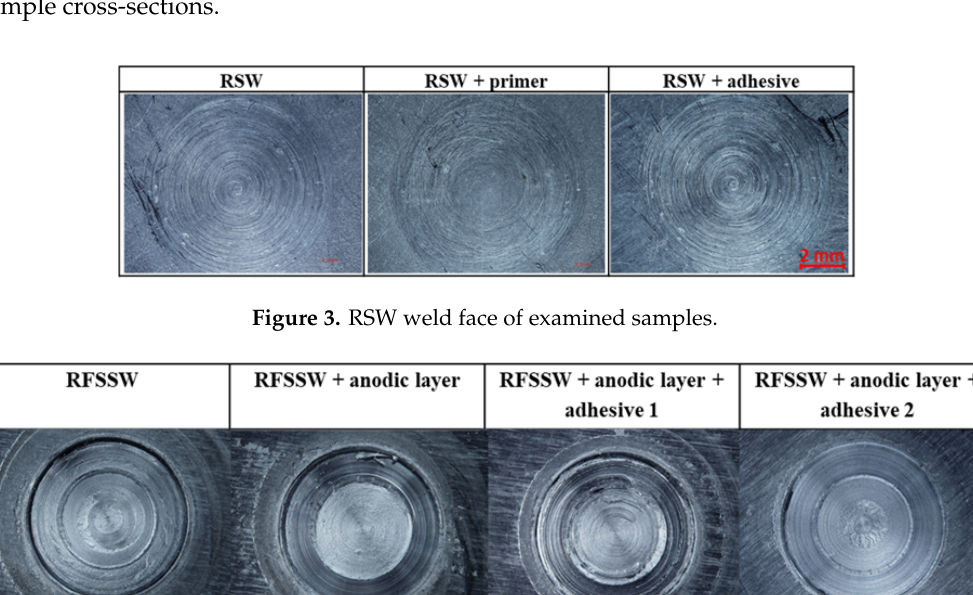
Figure 2. Scheme of microhardness indentations distribution in resistance spot welded (RSW) and refill friction stir spot welded (RFSSW) cross ‐ section.